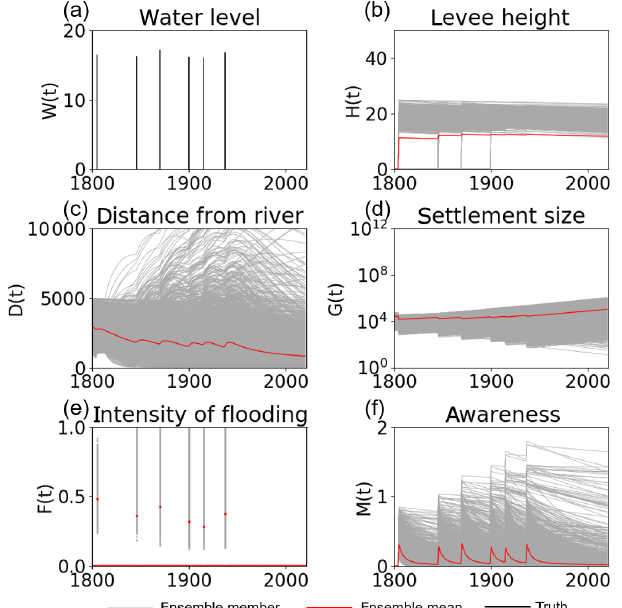
Figure 13. Time series of (a) the high water level W(t) , (b) the flood protection level (or levee height) H(t) , (c) the distance of the center of the mass of the human settlement from the river D(t) , (d) the size of the human settlement G(t) , (e) the intensity of flood- ing events F(t) , and (f) the social awareness of the flood risk M(t) simulated by the data assimilation experiment in which the real- world observations of G and H (green dots) are assimilated into the model, with 5000 ensembles in the real-world experiment in the city of Rome. The time step is annual. Gray and red lines are the ensemble members and their mean,